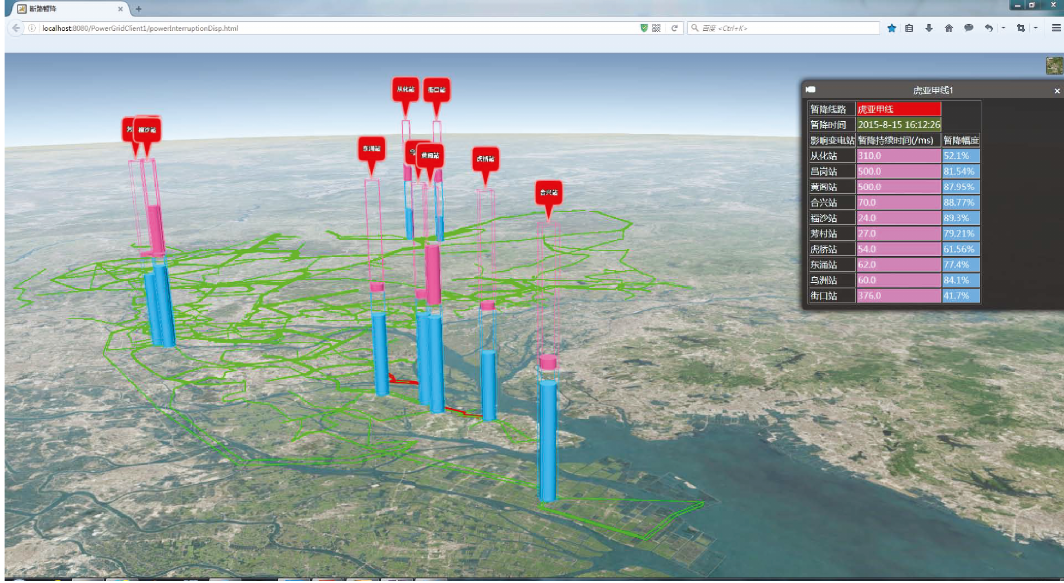
Figure 12: 3D display of voltage dips and breakdown transmission lines with geographic